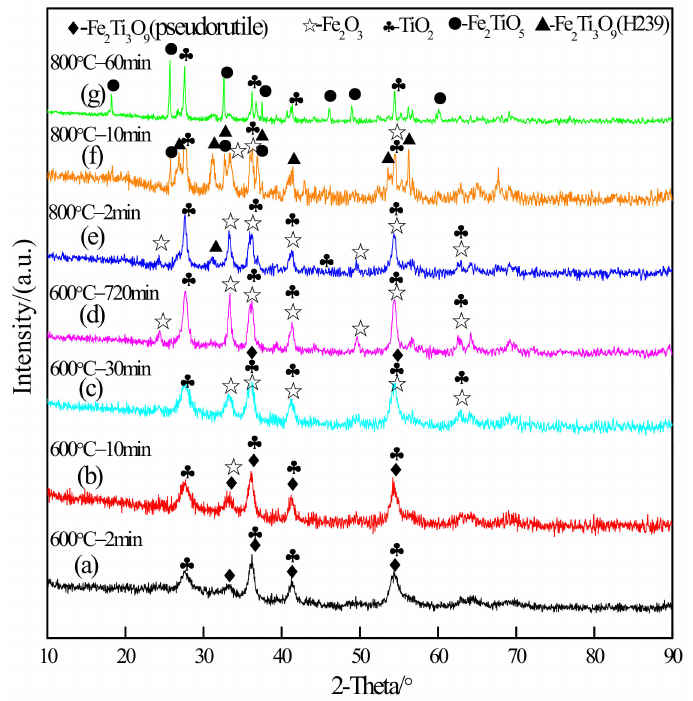
Figure 11. Chemical transformations of pseudorutile at different temperatures. ( a ) 600 ◦ C—2 min, ( b ) 600 ◦ C—10 min, ( c ) 600 ◦ C—30 min ( d ) 600 ◦ C—720 min ( e ) 800 ◦ C—2 min ( f ) 800 ◦ C—10 min and ( g ) 800 ◦ C—60